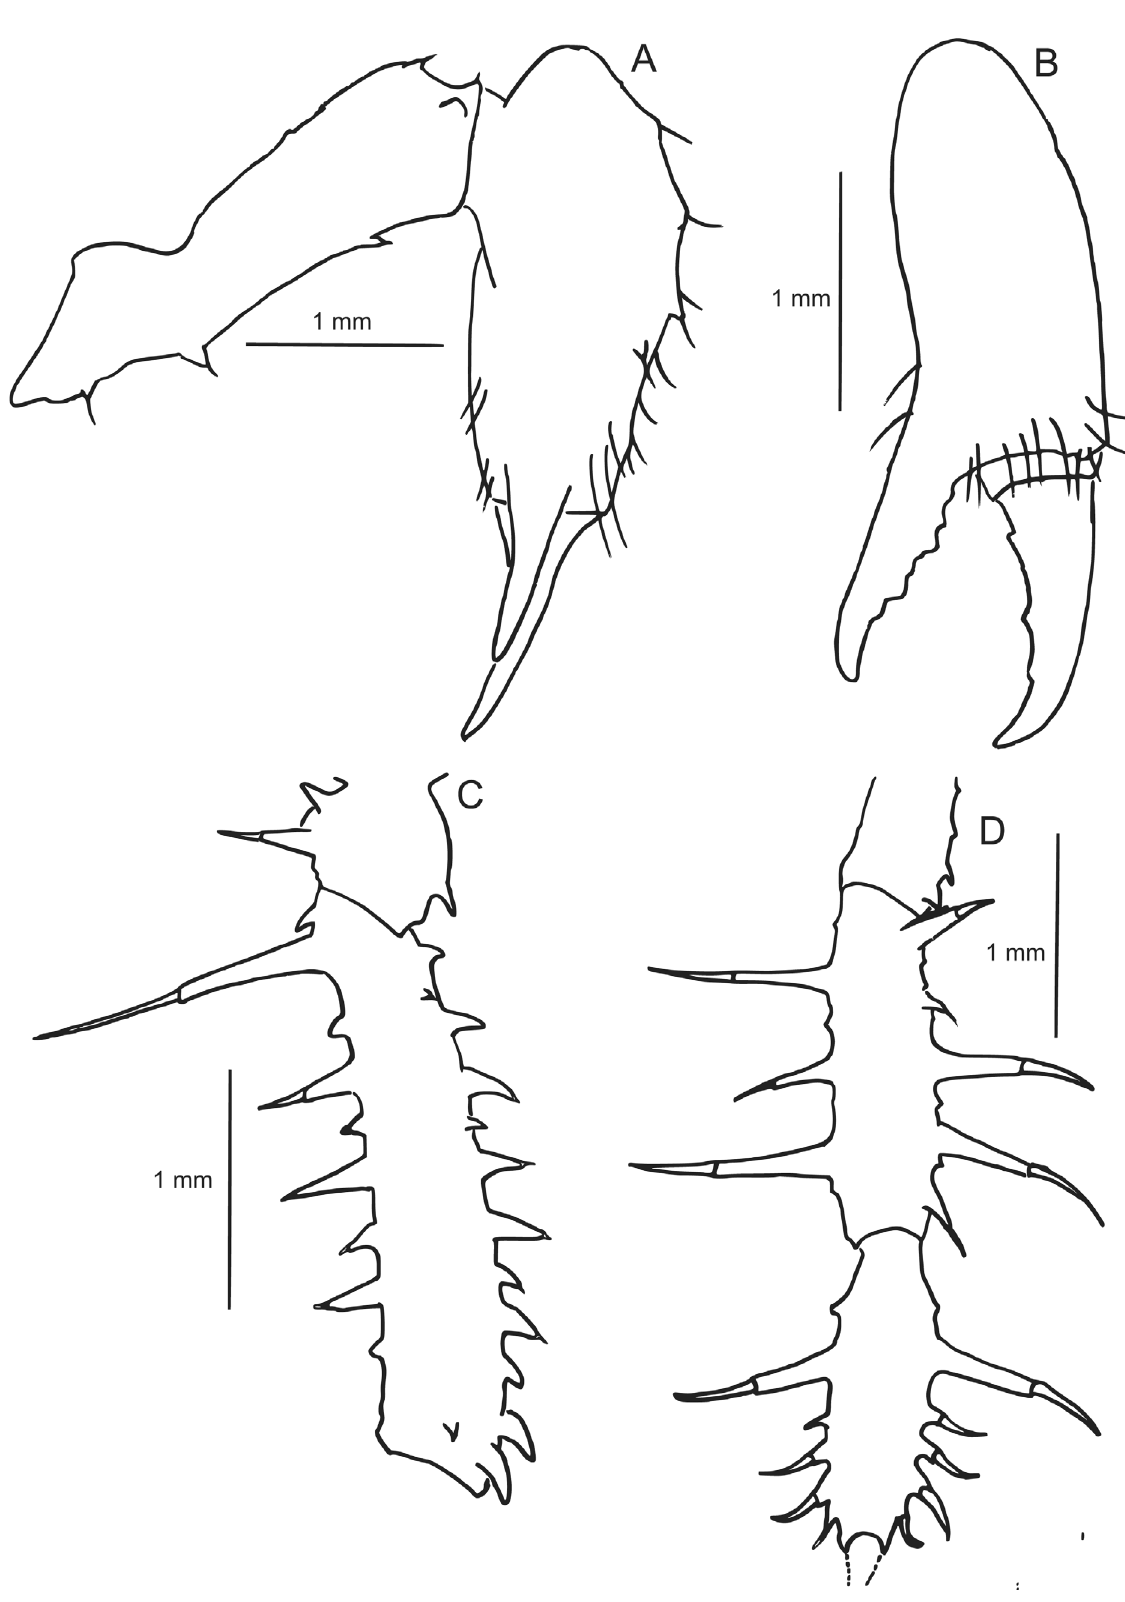
Fig. 1. Troglostygnopsis anophthalma Šilhavý, 1974, ♂, topotype (AMNH). A . Chelicera, mesal view. B . Chelicera, frontal view. C . Pedipalpal femur, mesal view. D . Pedipalpal tibia and tarsus, ventral